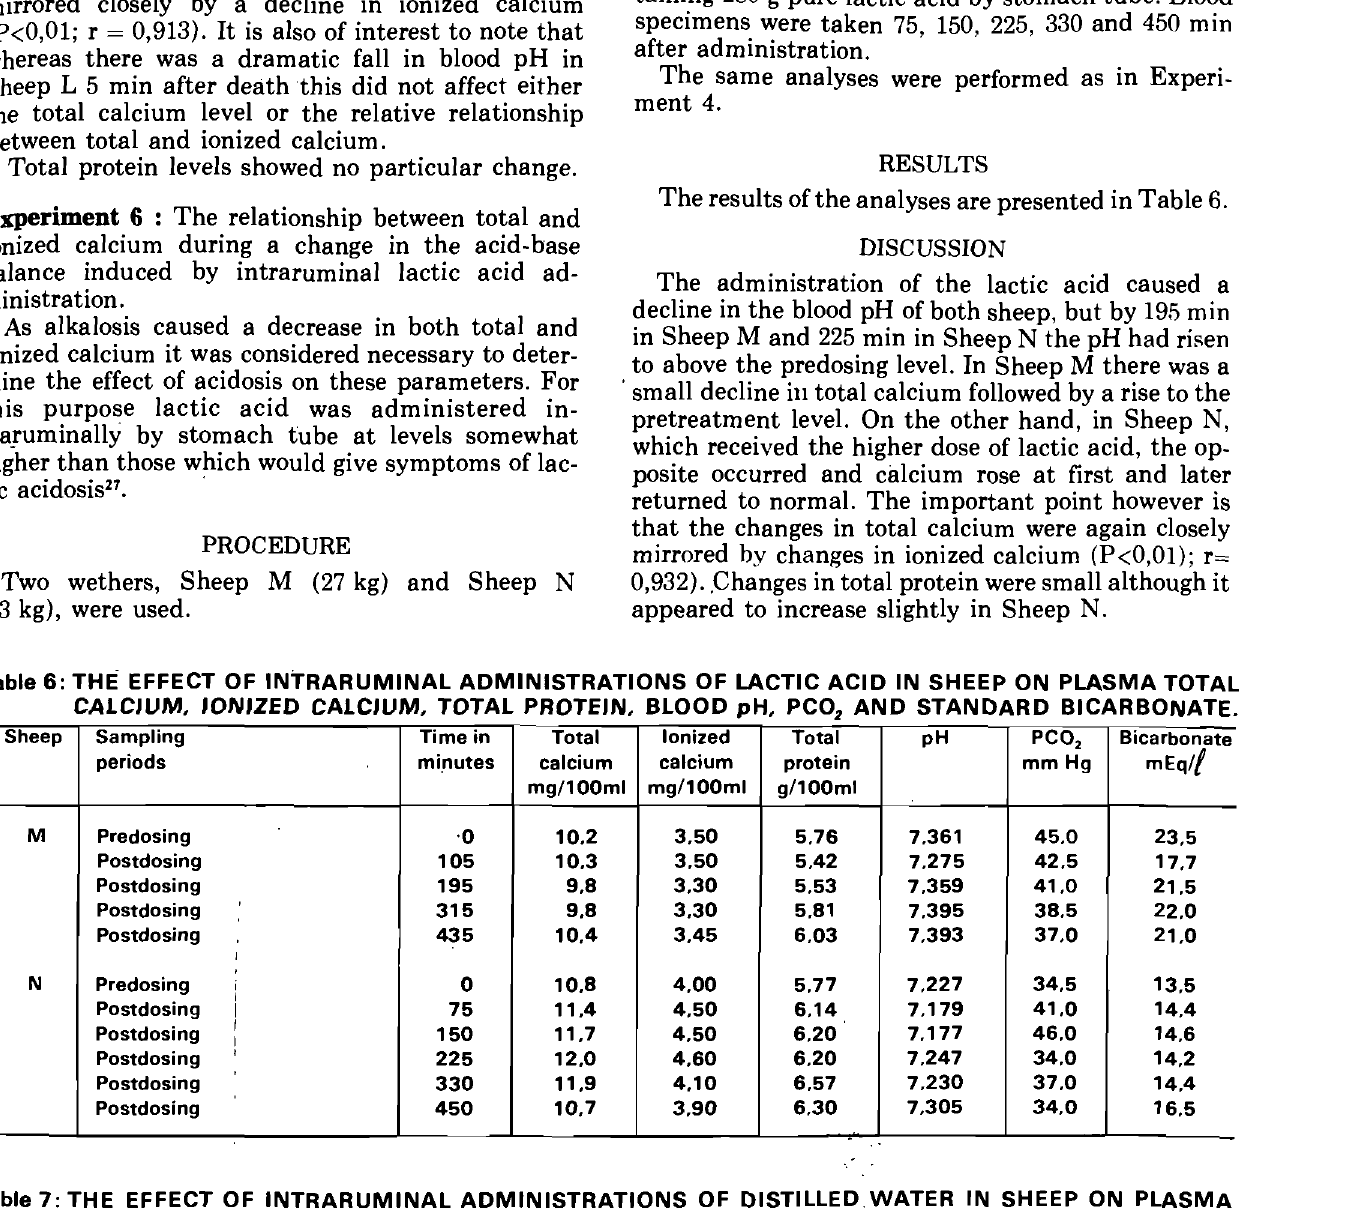
Table 7: THE EFFECT OF INTRARUMINAL ADMINISTRATIONS OF DISTILLED, WATER IN SHEEP ON PLASMA TOTAL CALCIUM, IONIZED CALCIUM. TOTAL PROTEfN. BLOOD pH. PCOz AND STANDARD BIRCARBONATE